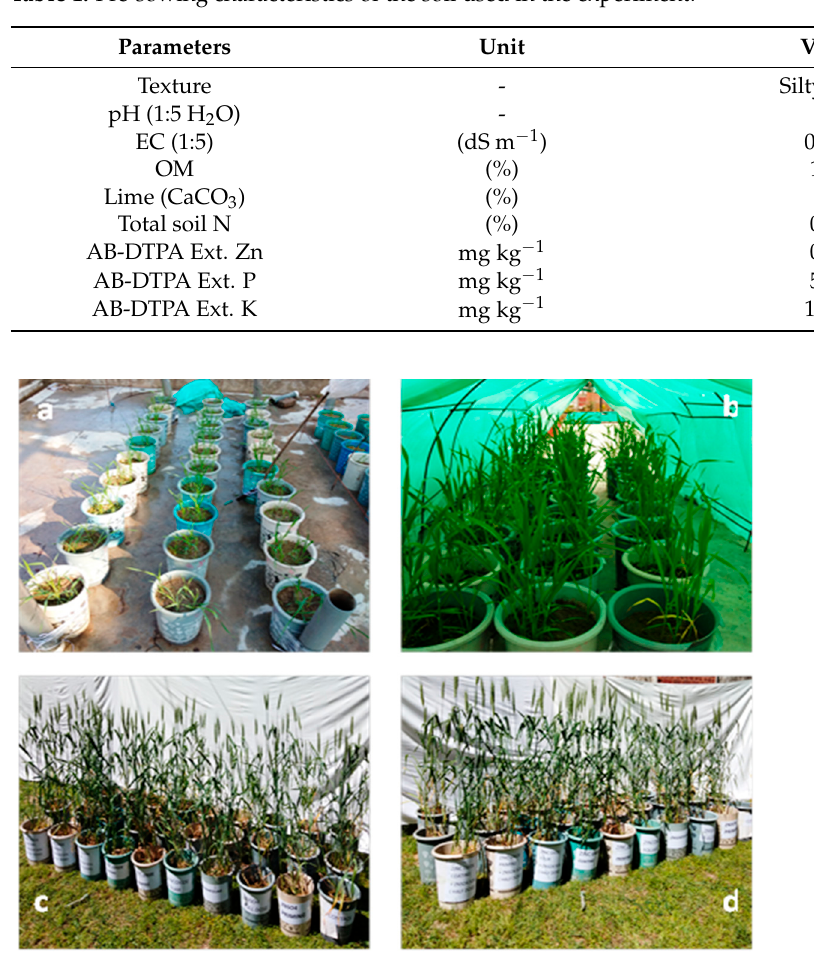
Figure 3. Pictorial view of the experiment at different stages (Source: Authors) ( a ) (20DAS), ( b ) (75DAS), ( c ) (130DAS), and ( d ) (155DAS) representing the periodic growth stages of wheat in pots.